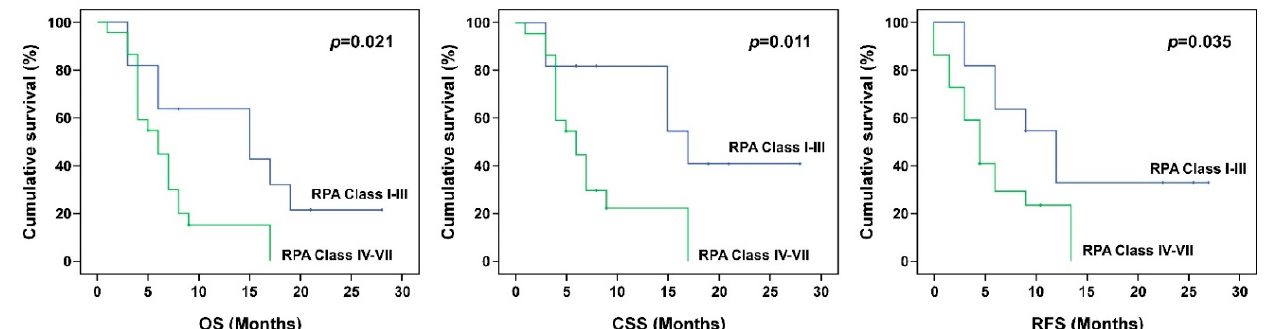
Biology 2021 , 10 , x FOR PEER REVIEW 9 of 17 Figure 3. Kaplan–Meier survival curve of tumors from RPA classes I–III and RPA classes IV–VII. A higher RPA class predicted poor